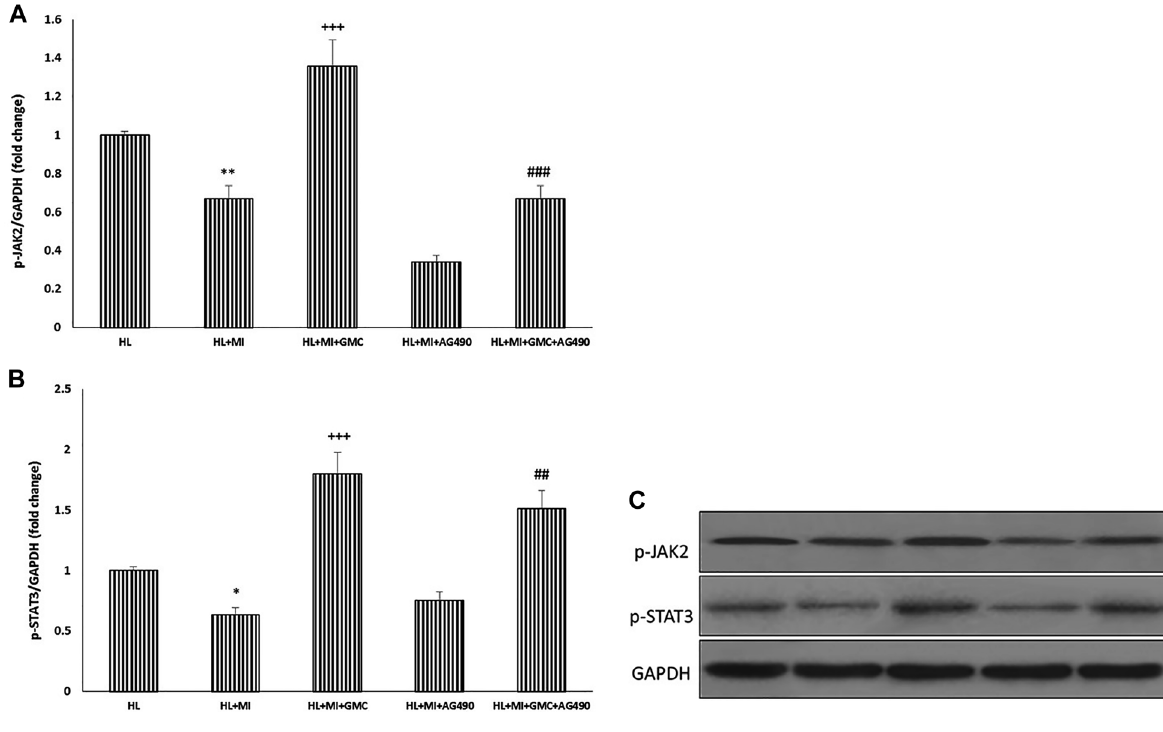
Figure 7: The effects of GMC administration on the expression of p-JAK (A), p-STAT3 (B), and related representative bands (C) following myocardial ischemia-reperfusion injury and their reversal by AG490 in hyperlipidemic (HL) rats. GAPDH was considered as an internal control of protein expression. Mean ± SD (n=7 in each group). MI: myocardial ischemia reperfusion injury; GMC, Ginsenoside-Mc1; AG490, JAK2 inhibitor. *p<0.05, **p<0.01 vs. HL group; +++ p<0.001 vs. HL + MI group; ## p<0.01, ### p<0.001 vs. HL + MI + GMC